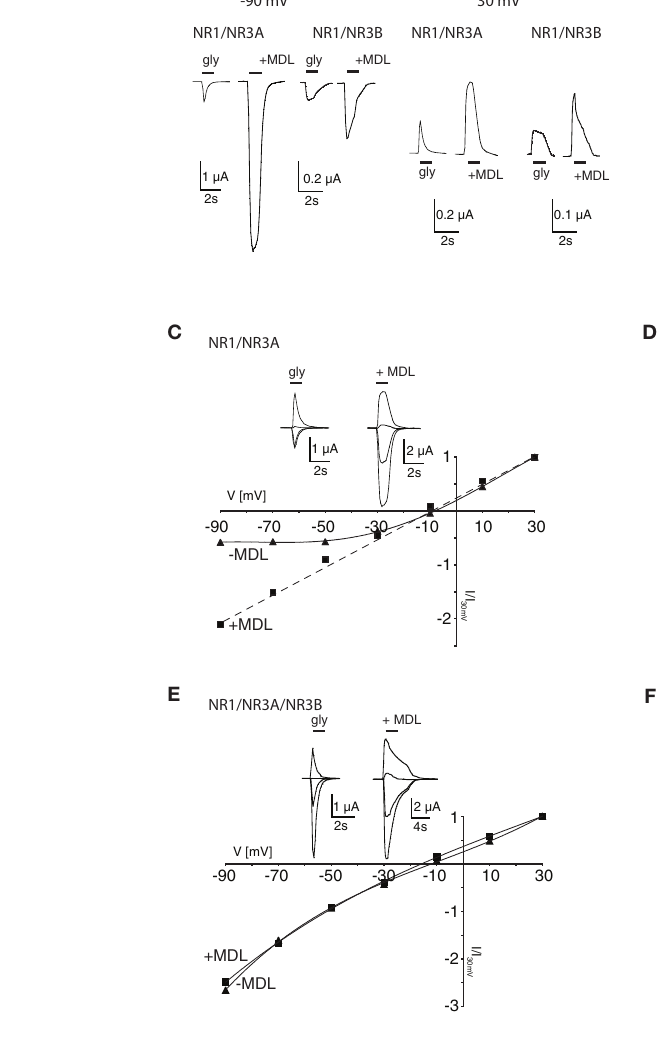
NR1/NR3A/NR3B (E) receptor currents recorded from − 90 to + 30 mV in 20-mV intervals activated by a saturated glycine concentration in the absence (triangle) and presence (square) of 200 nM MDL. Respective sample traces are shown above. Note that NR1/NR3A receptors display an ourwardly rectifying I–V curve in the presence of glycine alone, which becomes linear upon MDL-potentiation. (F) Quantifi cation of I–V relationships of NR1/NR3 receptors in the absence (black bars) and presence (gray bars) of 200 nM MDL by determining the rectifi cation index ( R ) of the currents measured at 40 mV above ( Δ+ 40 mV) and i 80 mV below ( Δ –80 mV) the respective reversal